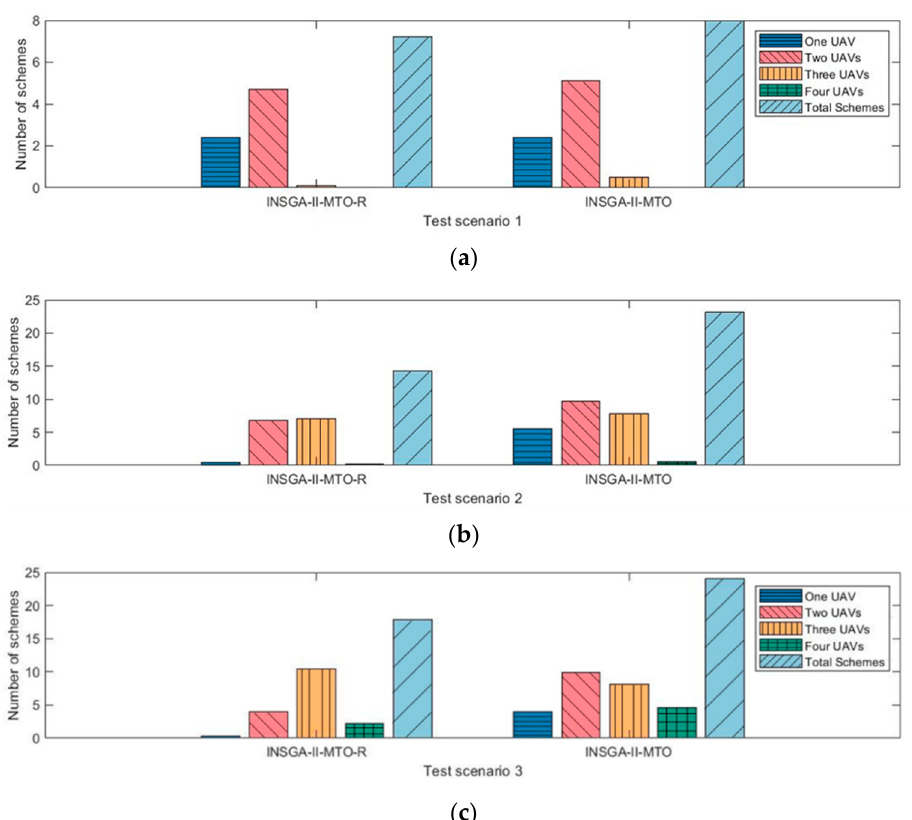
Figure 10. The number of various schemes obtained in experiments. ( a ) The number of schemes obtained by two algorithms in scenario 1. ( b ) The number of schemes obtained by two algorithms in scenario 2. ( c ) The number of schemes obtained by two algorithms in scenario